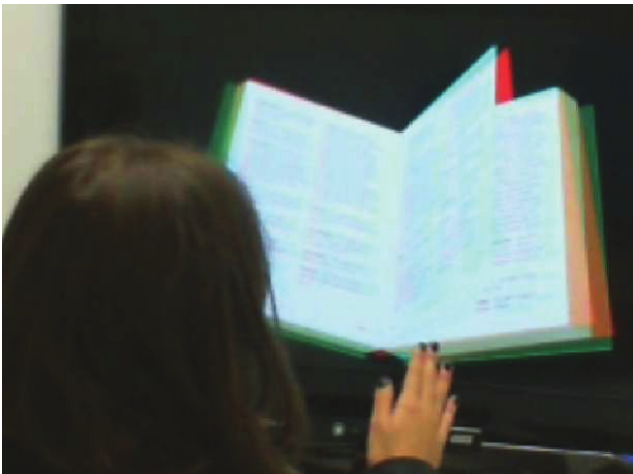
Fig. 3. Concept Image simulating the holographic interaction to be imple- mented in VIDA Project